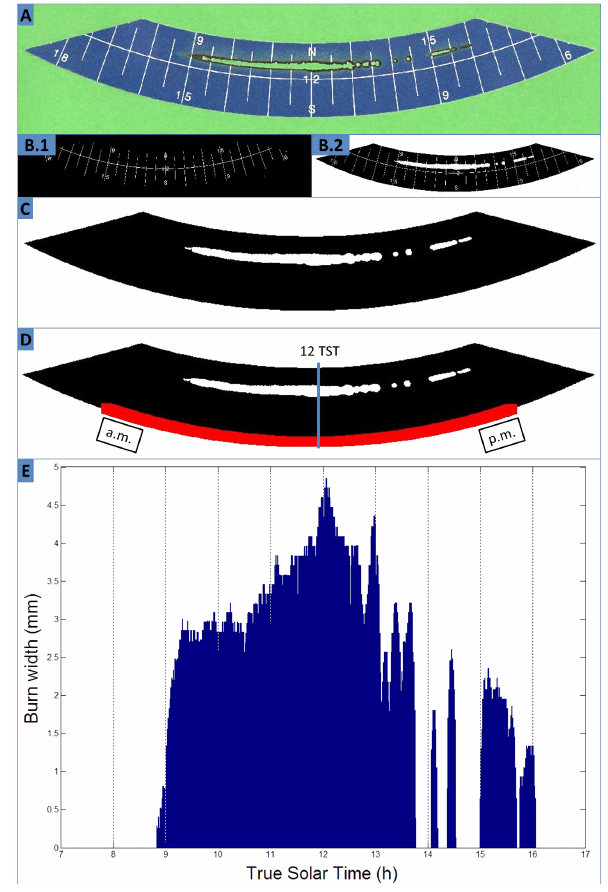
Figure 3. Steps of the semiautomatic method for retrieving informa- tion from the CSSR burned cards and for a certain day: (a) captured image, (b) treated image, (c) positioned image, and (d) measured burn width over